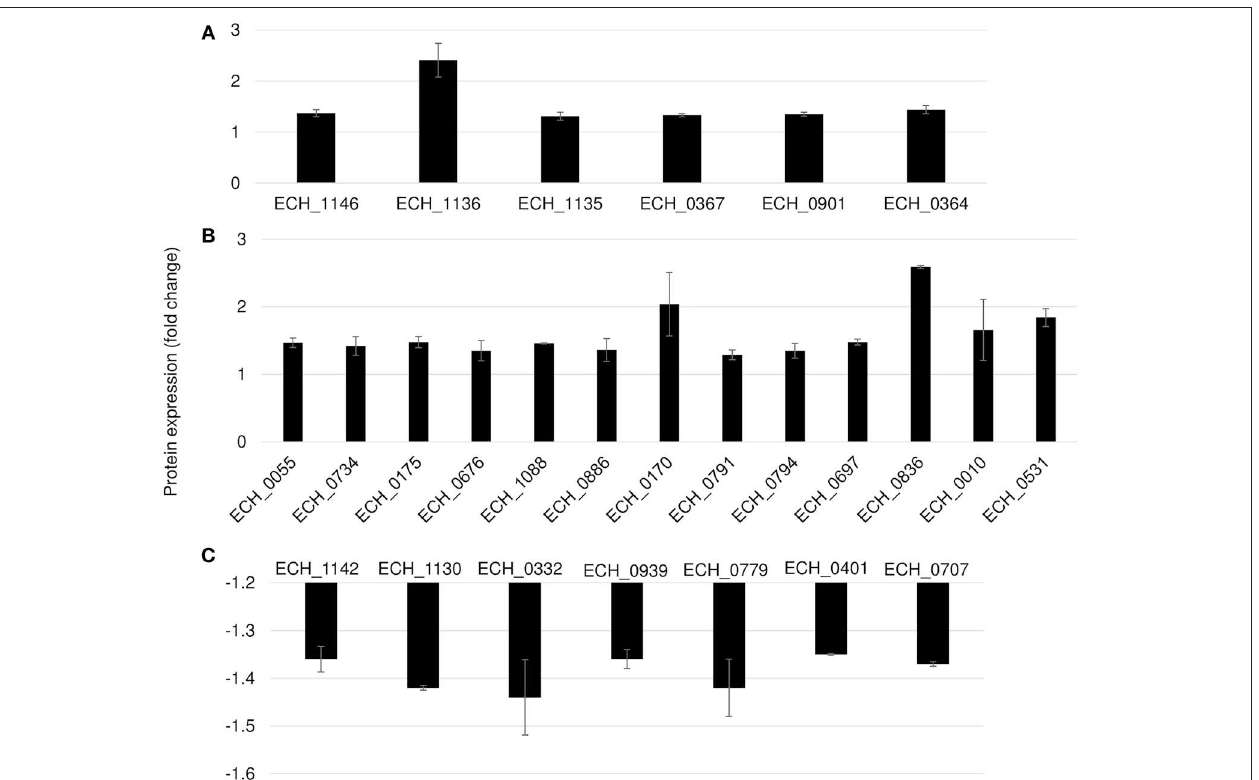
FIGURE 5 | Differentially expressed proteins in mutant ECH_0379. (A) p28 OMP’s and chaperons as upregulated, (B) metabolic enzymes and hypothetical proteins as upregulated, (C) p28 OMP’s and metabolic enzymes as downregulated. Protein expression was determined by comparing the expression values of mutant ECH_0379 and wildtype. The GenBank numbers are listed in Table 1 . Fold changes were considered significant with < 1% FDR at protein level and with a p -value was than 0.05.